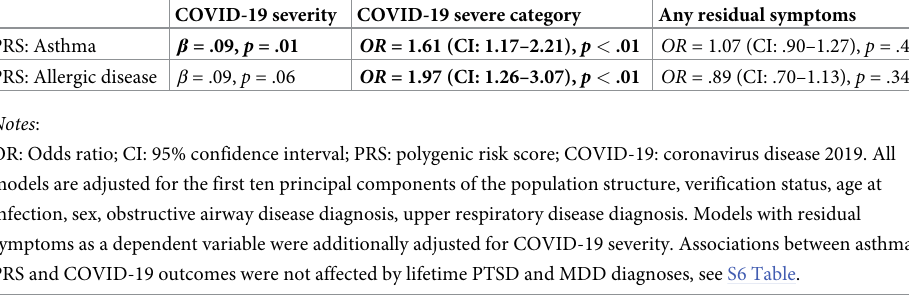
Table 2. Associations between allergic disease and asthma PRS and COVID-19 severity and residual symptoms in participants of European ancestry. COVID-19 severity COVID-19 severe category